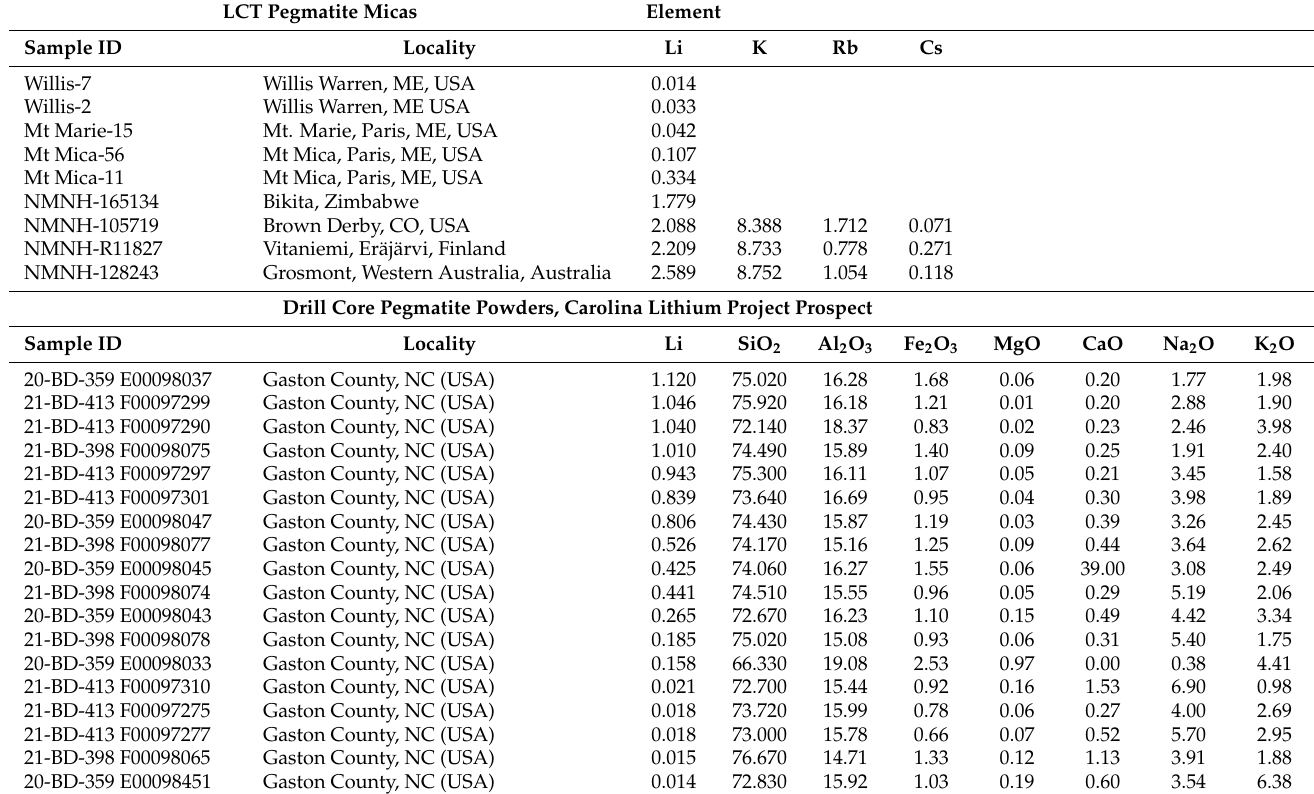
Table A2. Chemical analyses for mica calibration and pegmatite powder calibration curves (values in wt. %).